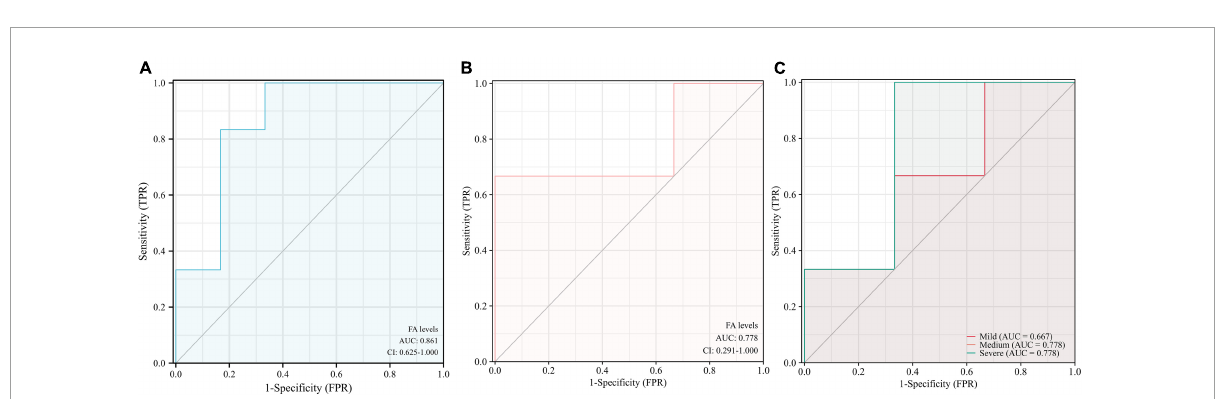
FIGURE6 Receiver operating characteristic curve analysis of urine FA levels in patients with AD. (A) Detection with Fluo-HPLC. (B) Detection with HPLC. (C) Different degrees of AD (mild, medium, and severe). ROC, receiver operating characteristic curve; AD, Alzheimer’s disease; FA, formaldehyde; HPLC, high performance liquid